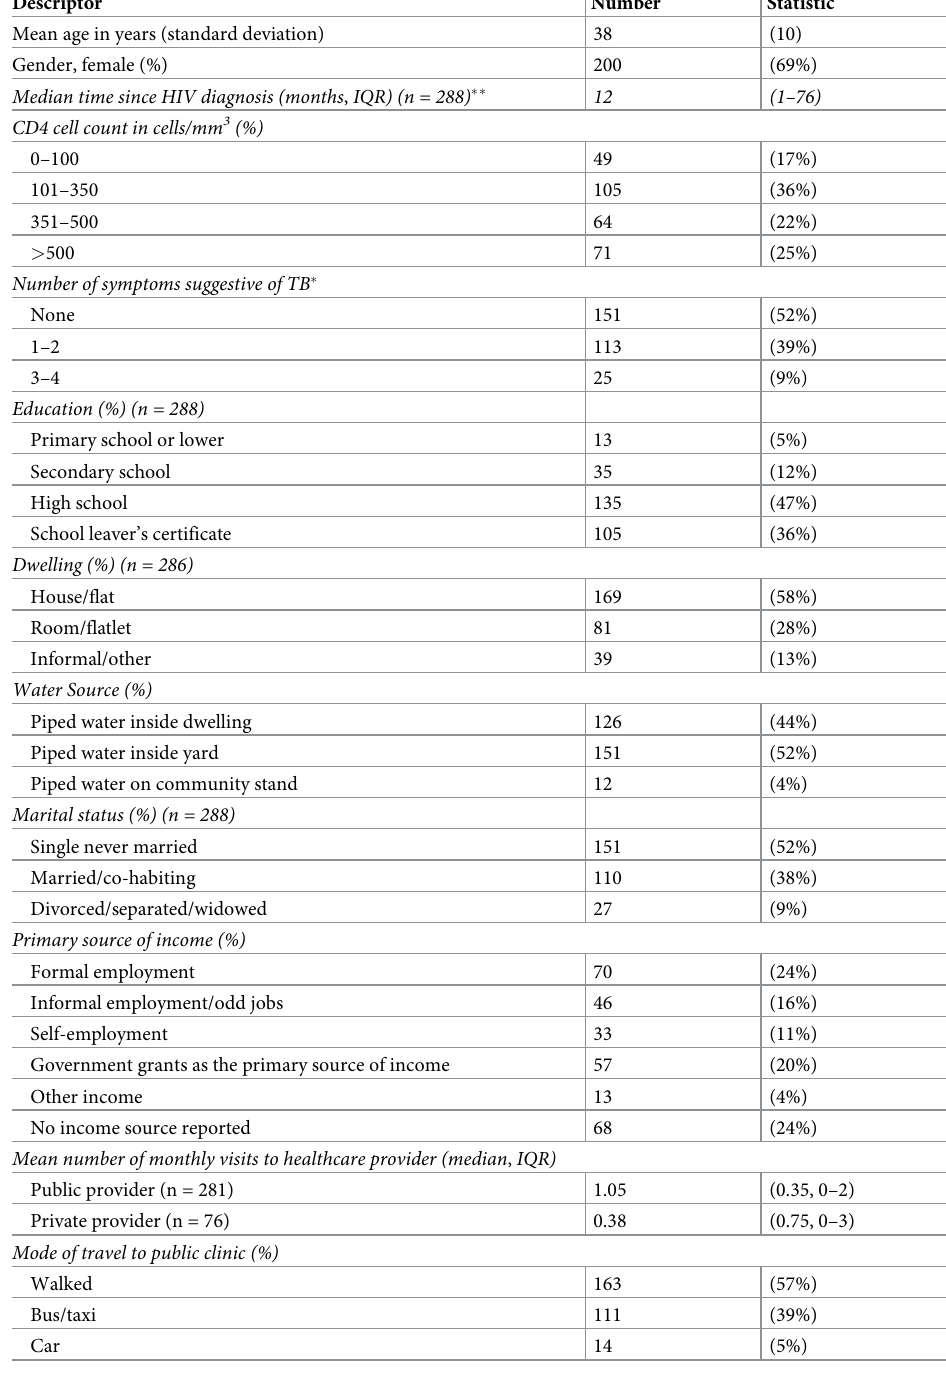
Table 1. Description of study participants (n =